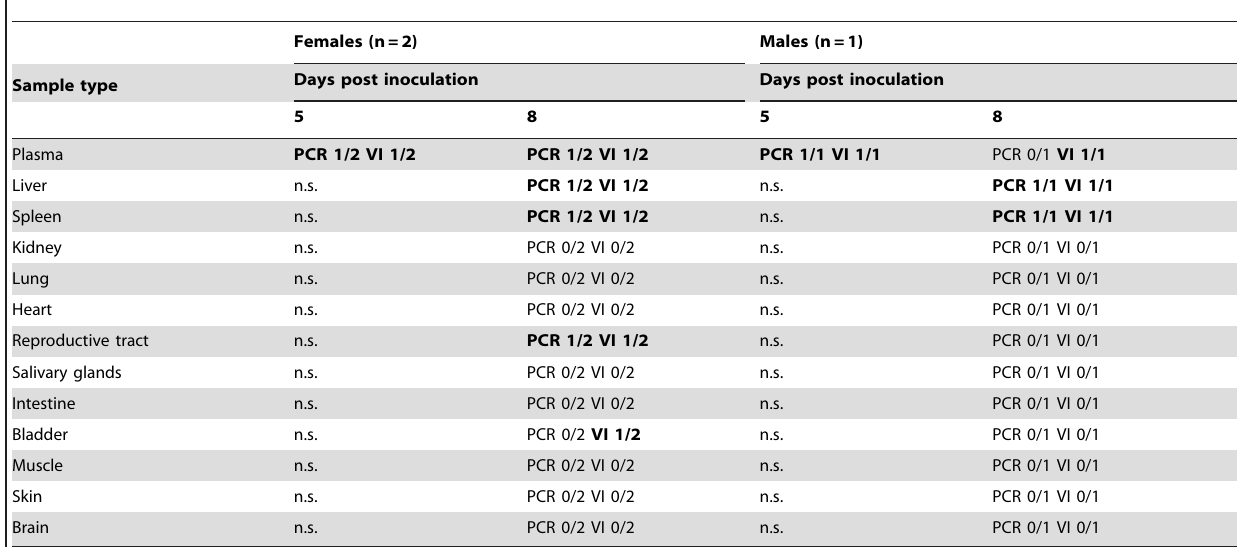
Table 3. PCR and virus isolation results in R. aegyptiacus bats inoculated subcutaneously with Hogan strain of MARV.